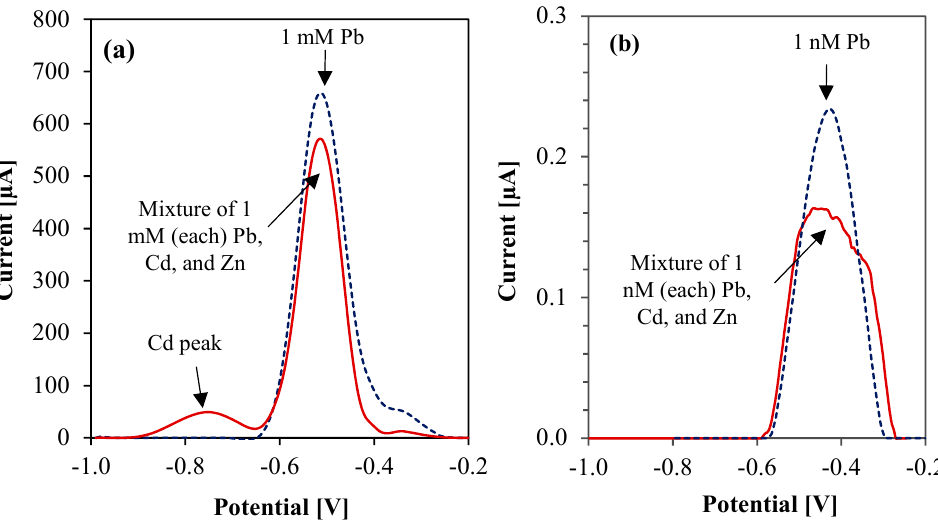
Figure 7. Interference study (ASV using parameters from Table 2) in acetate buffer (0.2 M, pH 5.2) with equally mixed concentrations of: ( a ) 1 mM Pb, Cd, and Zn (compared with 1 mM Pb alone), and ( b ) 1 nM Pb, Cd, and Zn (compared with 1 nM Pb alone).